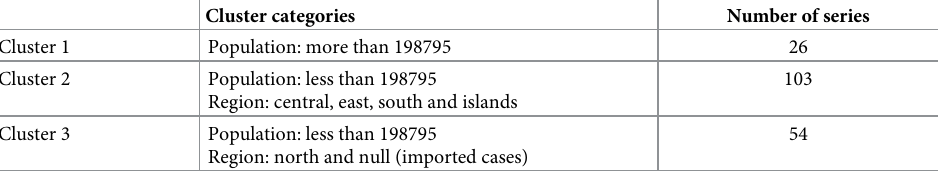
Table 3. Cluster categories of Taiwan COVID-19 confirmed infection cases by choosing three as the MOB depth, AIC as pruning option, and region, population, imported, administrative, and airport as domain-relevant